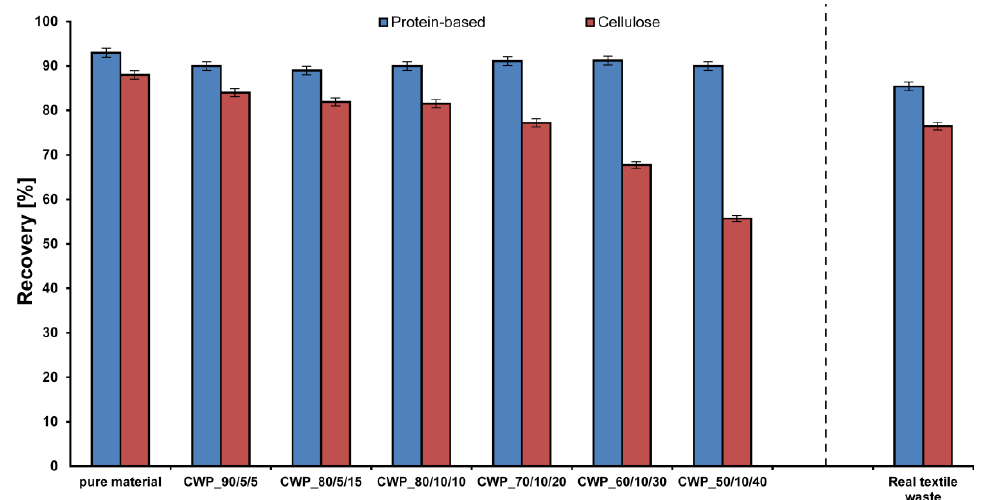
Figure 2. Recovery of protein and cellulose fibers building blocks after sequential treatment of textile waste and model mixtures with proteases and cellulases, respectively depending on cellulose (C), wool (W) and polyester (P) content. The data are given in (%) related to weight loss from the starting material. All experiments were performed in triplicates and plotted ± the standard deviation.